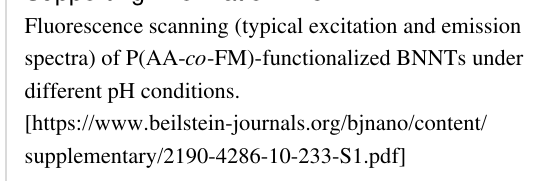
P(AA- co -FA)-functionalized BNNTs is excellent and they